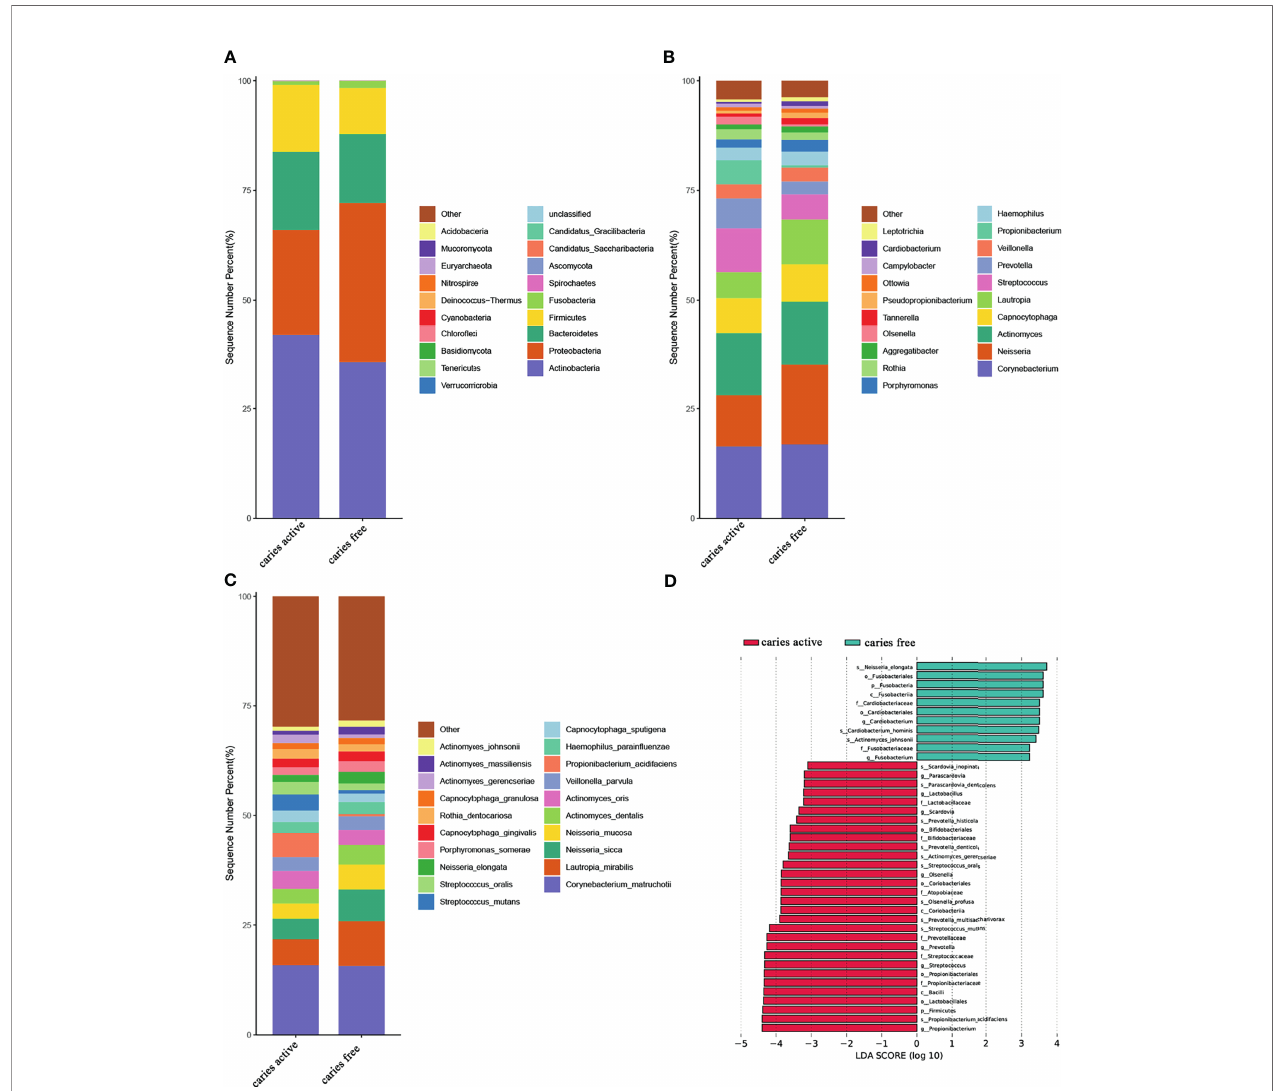
FIGURE 1 | Relative abundances of plaque microbial in caries active and caries free groups. (A – C) Relative abundances of phyla, genera, and species from the top 20 annotated microbial taxa, respectively, are shown in a bar plot. (D) Signi fi cant differences in relative abundance of plaque microbial taxa between the caries active and caries-free groups, as identi fi ed by linear discriminant analysis (LDA) effect size analysis (LEFSe) (DUNN test, p <